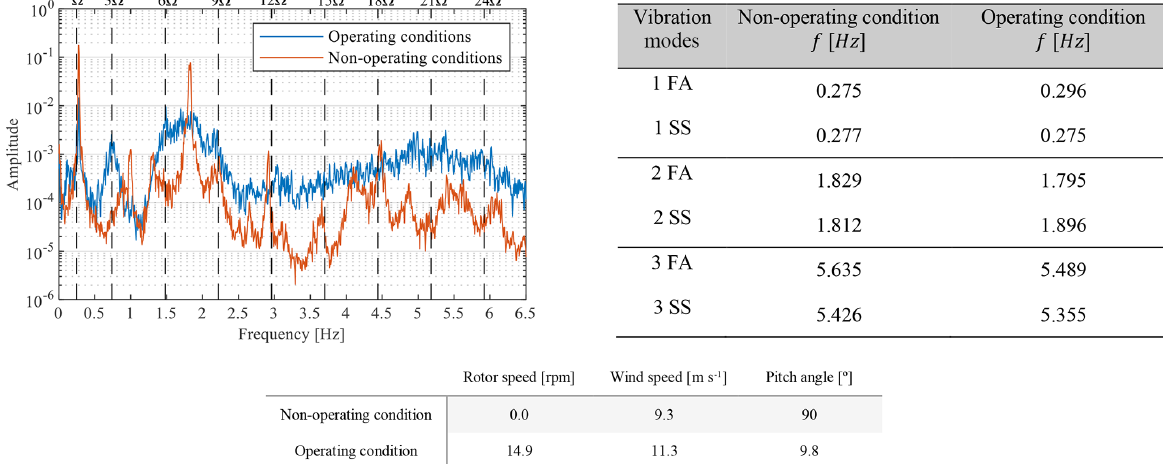
Figure 6. Ambient-vibration test results for wind turbine 1 in operating and non-operating conditions: average power spectra and natural frequencies (results obtained from single 10min observation set-ups with very low variance of the environment and operational